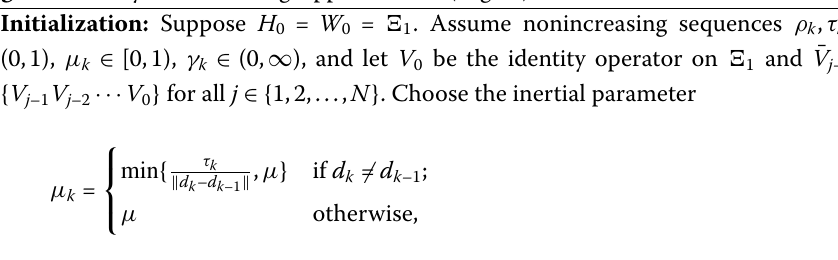
Algorithm 1 Hybrid Shrinking Approximants